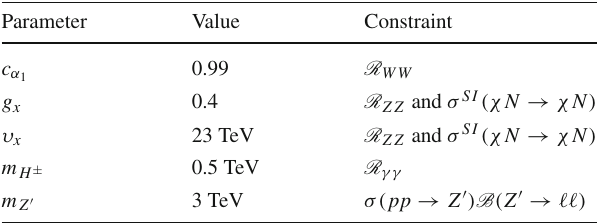
Fig. 4 Diphoton rate as a function of the charged scalar boson mass, m H ± . Values of R γγ allowed at 1 σ and 2 σ are represented by the thin (yellow online) and broad (green online) horizontal bands, respectively. While vertical band (orange online) is the excluded region for m H ± by total decay width of the Higgs boson Table 3 The setting of the values for the model parameters